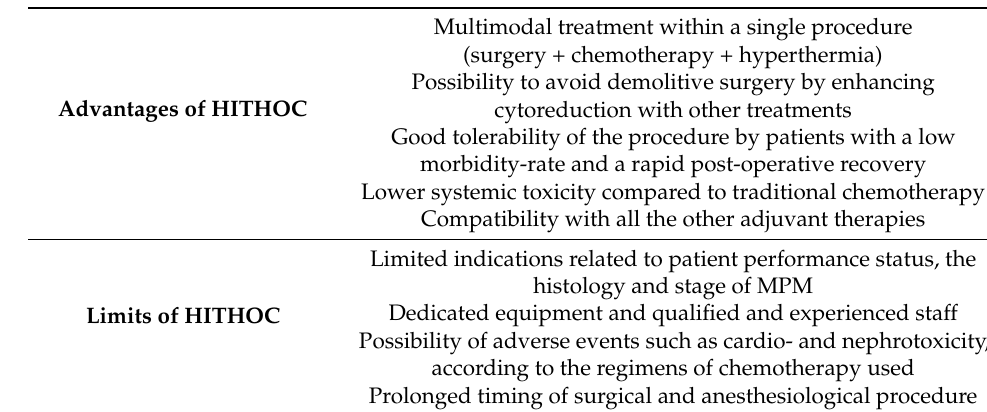
Table 1. Advantages and limits of HITHOC.